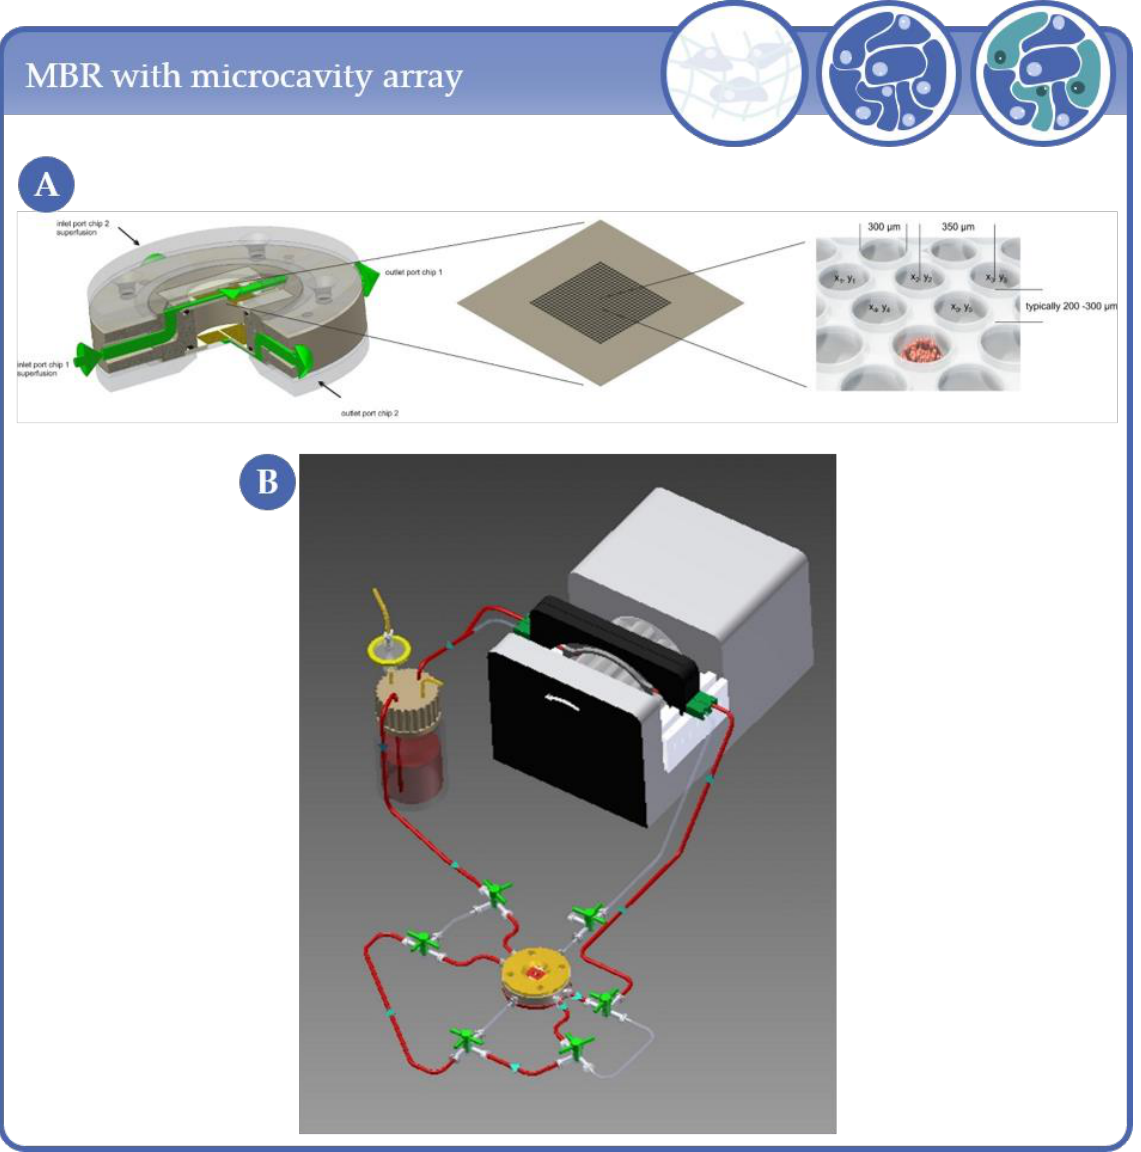
Figure 9. ( A ) MBR and microcavity array. Typical arrays of a 1 × 1 cm 2 area consist of 634 microcavities with 300 µm diameter and 250 µm depth. ( B ) Schematic representation of the microcavity array-based bioreactor closed circulation loop comprising the bioreactor, a medium reservoir and a cassette pump.